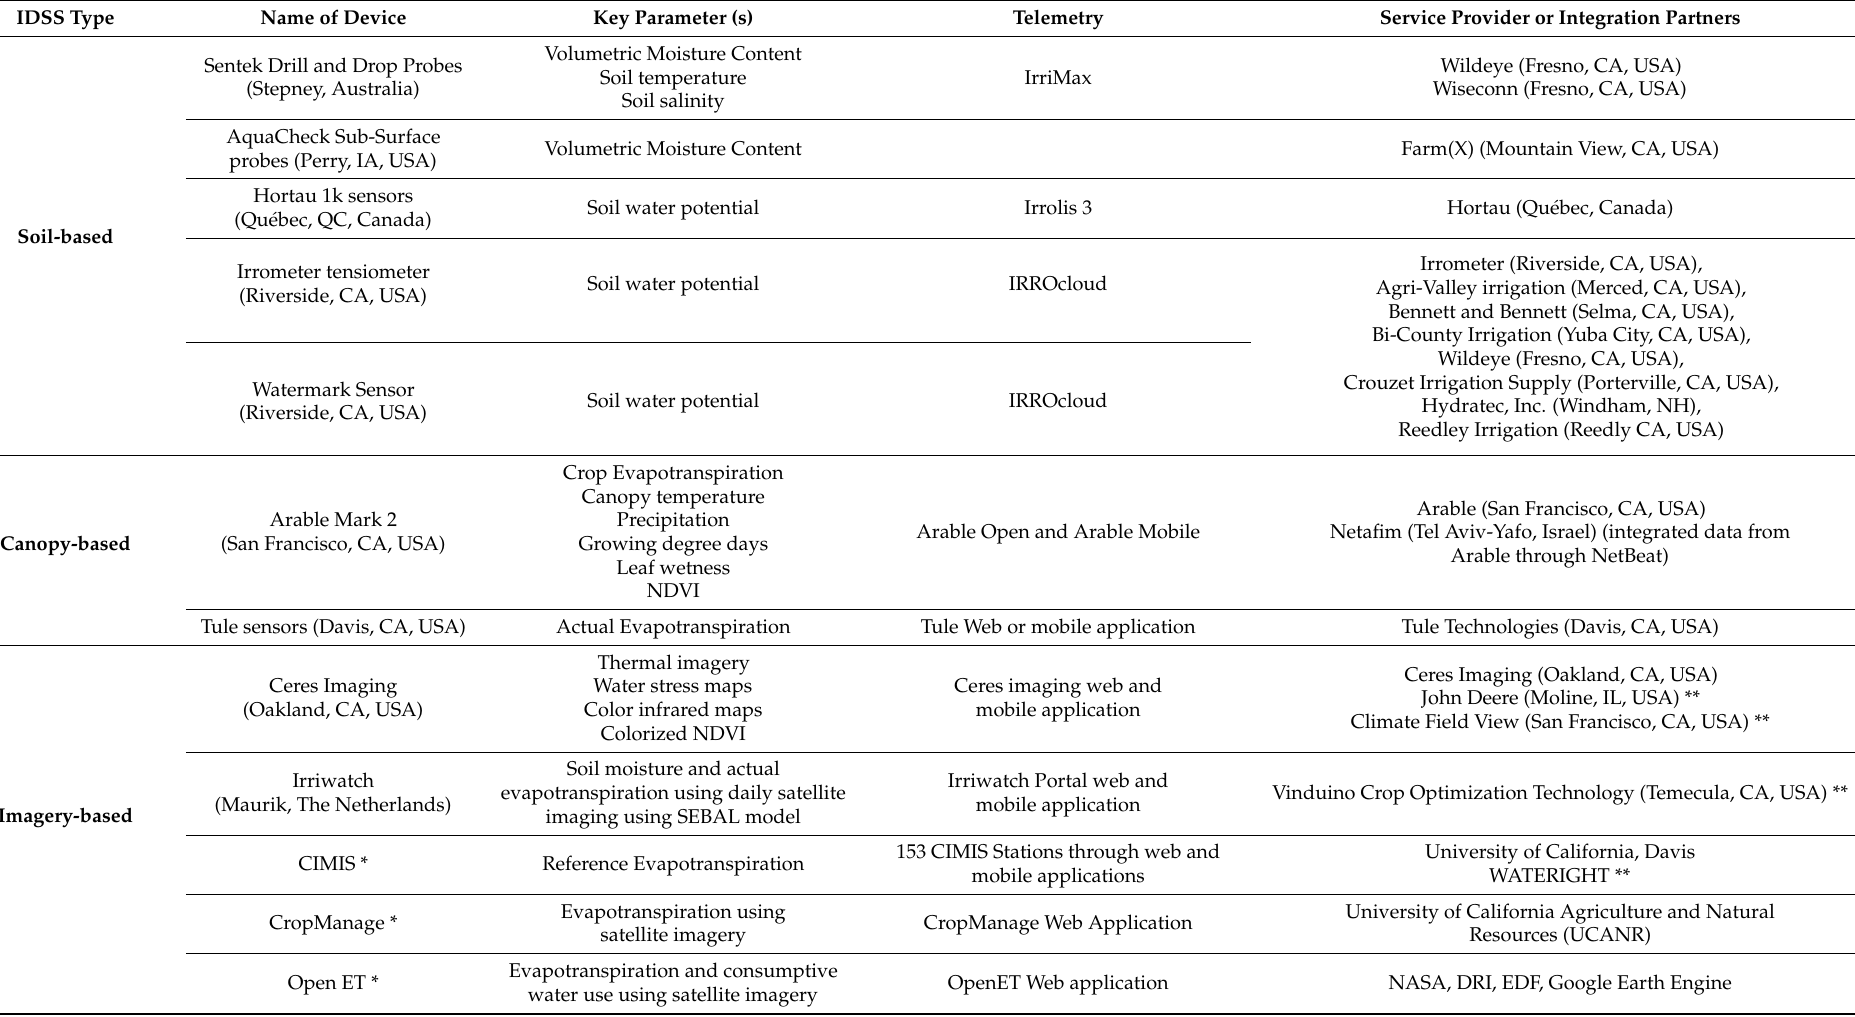
Table 2. List of commonly available IDSS for agricultural